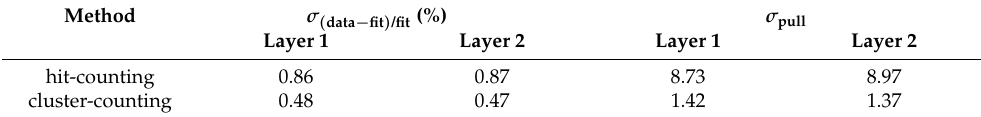
Figure 63. Gaussian fit of the relative difference between data and fitted luminosity curve using cluster-counting for layer 1 in LHC fill 6677. Taken from Ref. [18]. Table 33. Precision of TPX3 luminosity measurements for layers 1 and 2 for hit- and cluster-counting in LHC fill 6677. The width of the Gaussian fit σ ( data − fit ) /fit gives the precision of the measurement, and σ pull gives the width of the pull distribution fit with statistical uncertainties only. Taken from Ref. [18].